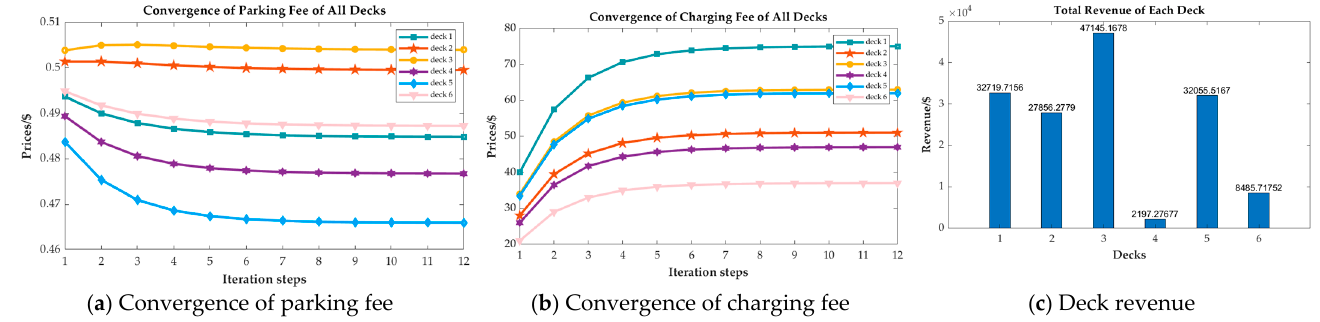
Figure 3. The convergence of parking/charging fees of all decks and deck revenue.